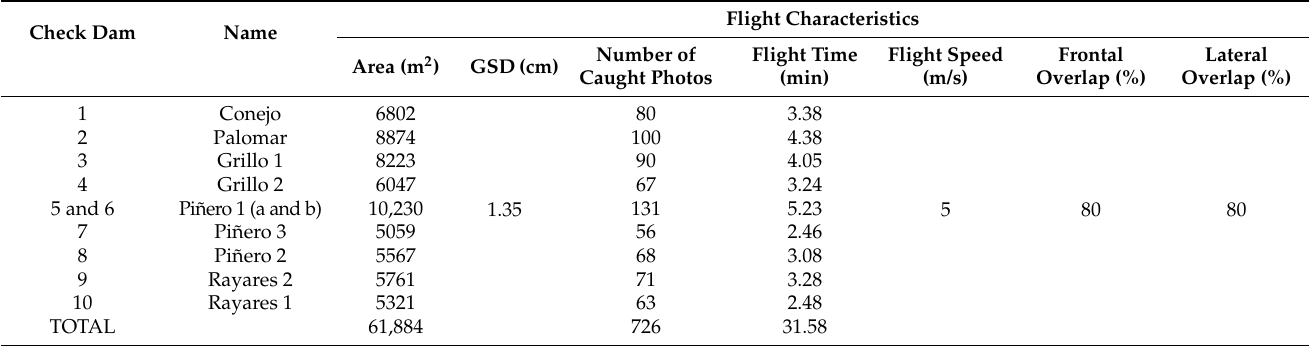
Table 2. Configuration data about the UAV flight plans for aerophotogrammetric surveys in Sierra de Los Donceles forest (Castilla-La Mancha,